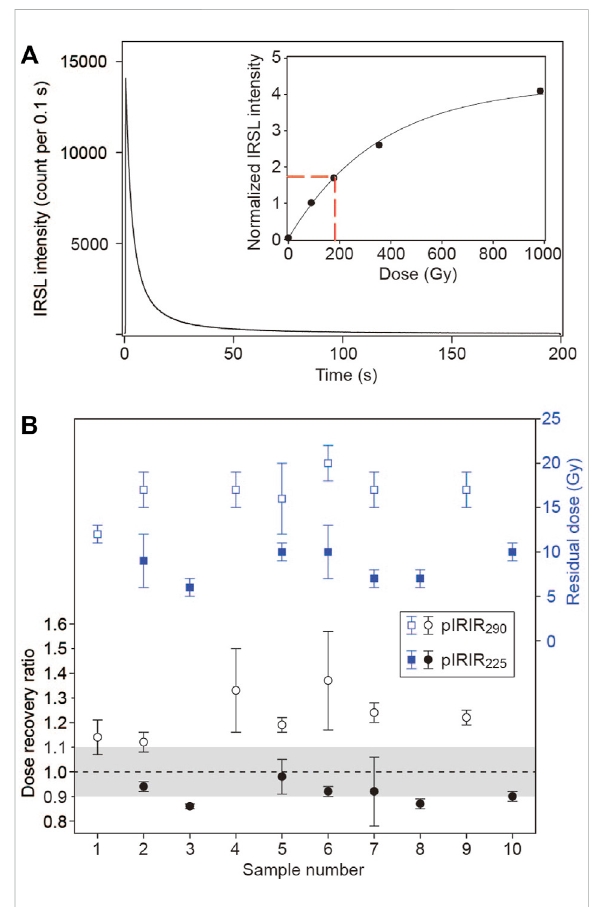
FIGURE 4 (A) Natural decay curve and a dose-response curve (inset) of pIRIR 225 of K-feldspar coarse grains in sample gsj17123. (B) Results of the dose-recovery test and observed residual dose for pIRIR 225 and pIRIR 290 in selected samples. 1: gsj17097, 2: gsj17101, 3: gsj17111, 4: gsj17115, 5: gsj17123, 6: gsj17134, 7: gsj17139, 8: gsj17142, 9: gsj17143, 10: